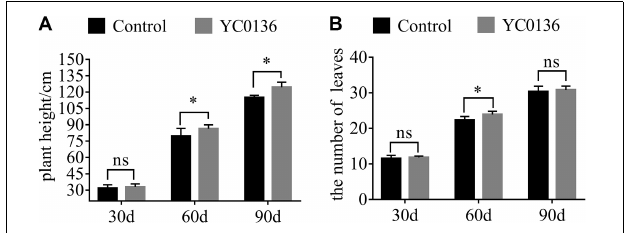
FIGURE 2 | Effects of strain YC0136 on agronomic characteristics of tobacco at different growth stages. Two hundred milliliters of water with 5 mL of YC0136 cell suspension was poured into the rhizosphere of tobacco. In the control group, the cell suspension was replaced with 5 mL of LB medium. Plant height and leaf number were recorded every 30 days. (A) Statistical results for tobacco plant height. Plant height is the distance from the surface stem base to the first capsule base. (B) Statistical results for tobacco leaf number. Number of leaves is the number of leaves from the stem bottom to the top of the first flower branch. “ ∗ ” indicates a significant difference at the p < 0.05 level in t -tests. “ns” means that there is no significant difference at the p < 0.05 level. A total of two treatments were set up in the pot experiments with 10 replicates for each treatment at the beginning of the experiment. At 90 days after inoculation, there were five replicates. Error bars indicate the SD from the mean.